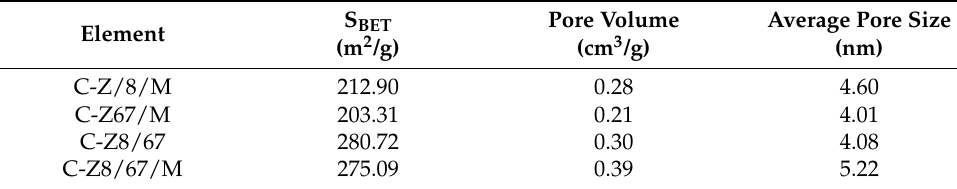
Table 1. Specific surface area and pore parameters of different samples.